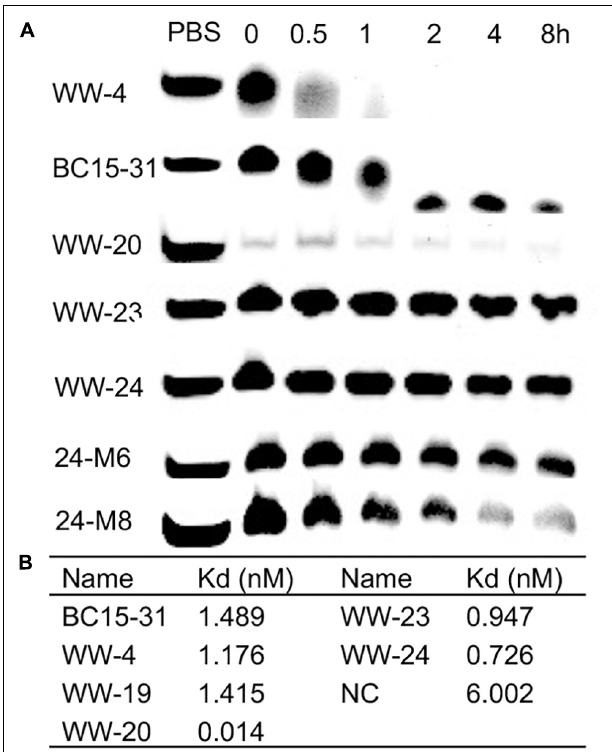
FIGURE 5 | (A) Serum stability of representative PS-modified BC15-31s (20% FBS; 20 pmol aptamer). (B) Binding affinity of PS-modified BC15-31s to hnRNP